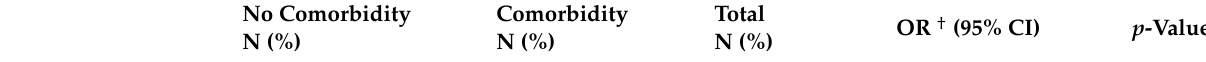
Table 1. Age at diagnosis, sex, deprivation level and ethnicity according to the comorbidity status amongst patients with Diffuse Large B-cell ( n = 27,379) or Follicular lymphomas ( n =14,043) in England between 2005 and